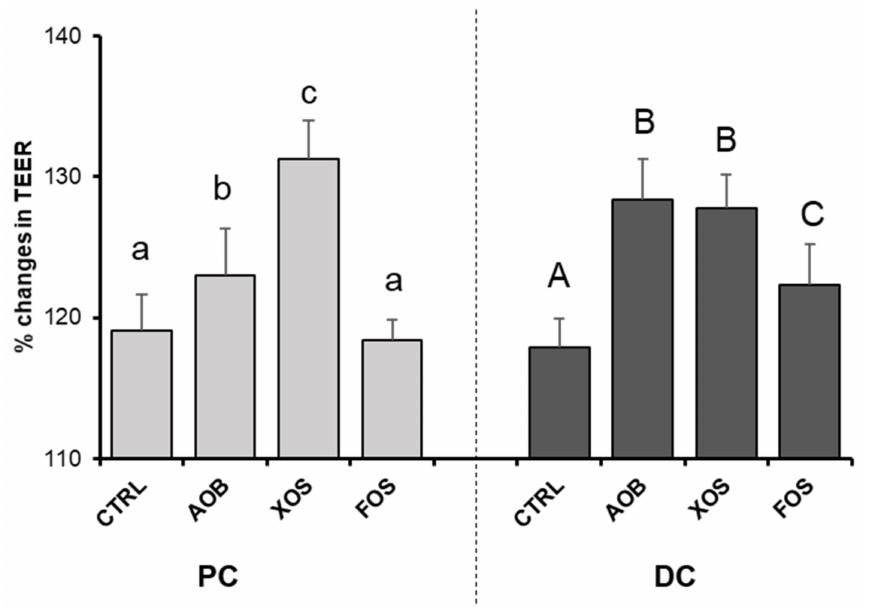
Figure 7. Changes in TEER (transepithelial electric resistance) for donor 2, upon treatment with AOB, XOS and FOS versus a blank control for PC and DC. Data are averages of six technical replicates with standard deviation STDEV ( n = 6). CTRL = control; AOB = antioxidant blend; XOS = xylooligosaccharides; FOS = fructooligosaccharides; PC = proximal colon; DC = distal colon. Significant differences ( p < 0.05) are indicated with small letters (a, b, c) for the proximal colon and capital letters (A, B, C) for the distal colon. Bars with different letters are significantly